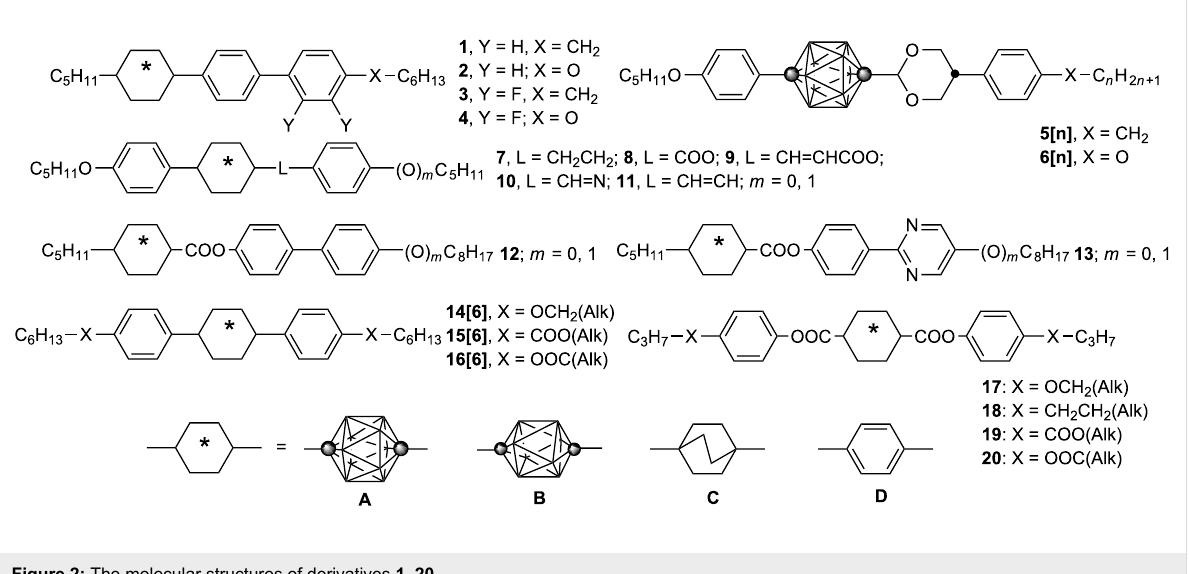
Figure 2: The molecular structures of derivatives 1 – 20 .